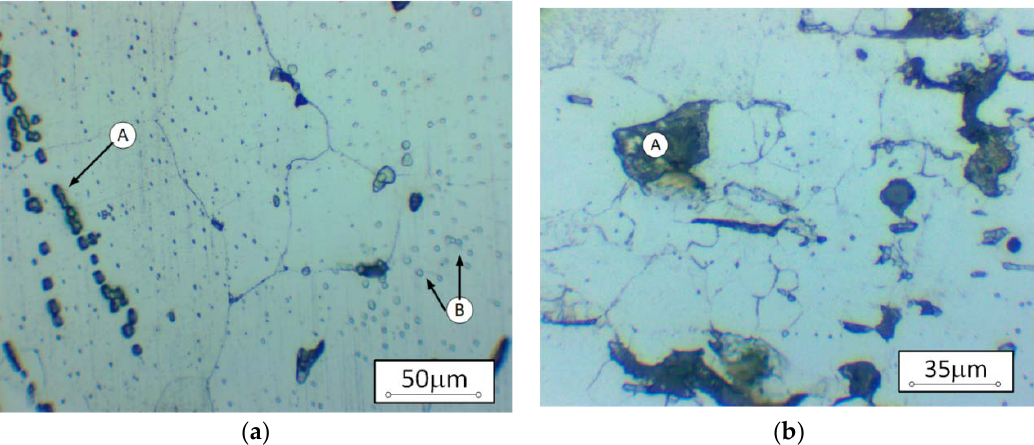
Figure 2. Typical non-metallic inclusions pattern for Eiffel puddle iron (non-etched state, light microscopy). ( a ) Typical non-metallic inclusions chains deformed in the rolling direction; ( b ) noticeable large non-metallic inclusions and slags; the size of the slags often exceeds 10 µm.